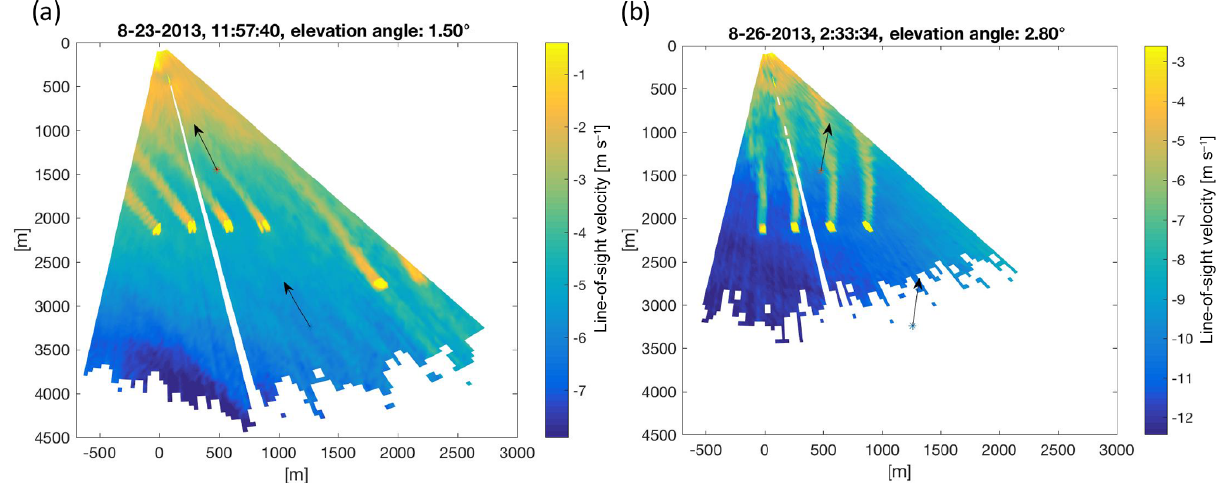
Figure 3. Color maps of line-of-sight velocity measured by the scanning lidar during two PPI scans performed at 11:57UTC (06:57LDT) on 23 August 2013 (a) and at 02:33UTC (21:33LDT) on 26 August 2013 (b) . The scanning lidar is located in the origin of the coordinate system. The two arrows show wind direction as measured by the profiling lidars WC-1 and WC-2 at 80ma.g.l.